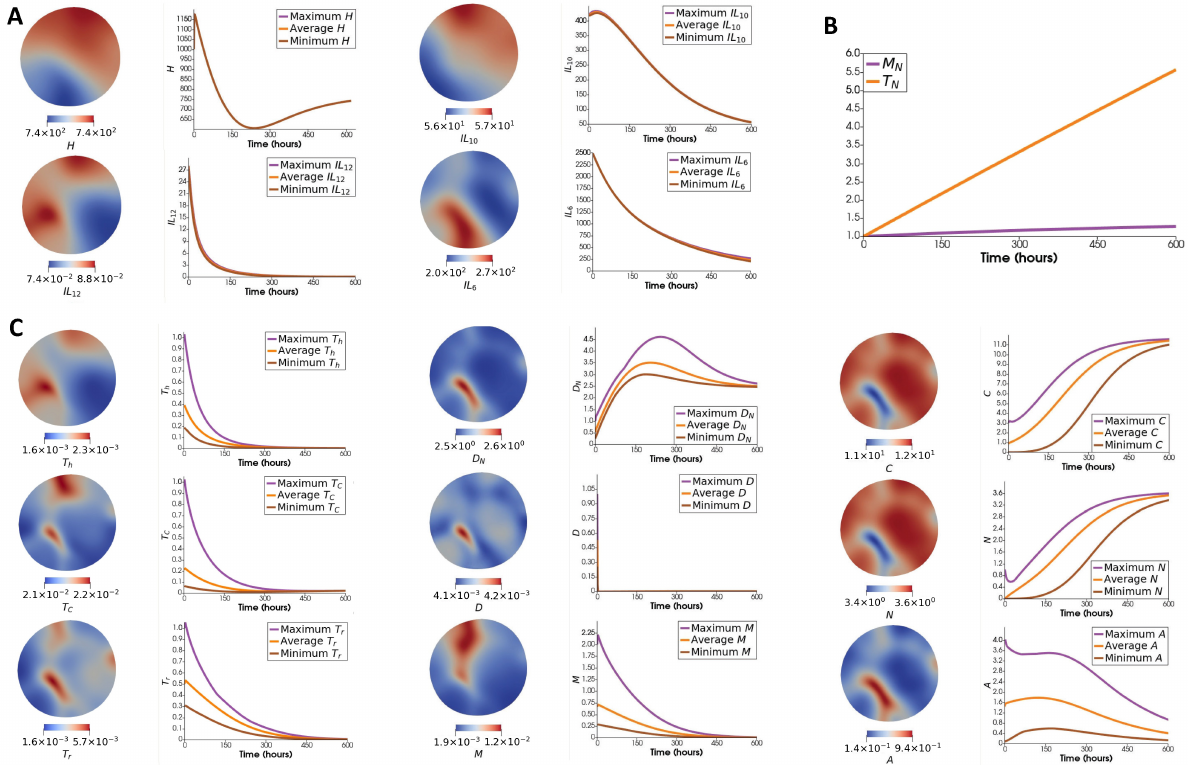
Figure 5. Results with no flux of immune cells. ( A ) Column 1 : Spatial distribution of cytokines. Column 2 : Maximum, average, and minimum concentration (ng/mL) of each cytokine over the whole domain with respect to time. ( B ) Evolution of naive T cells and naive macrophages. ( C ) Column 1 : Spatial distribution of cell types. Column 2 : Maximum, average, and minimum number of each cell type over the whole domain with respect to